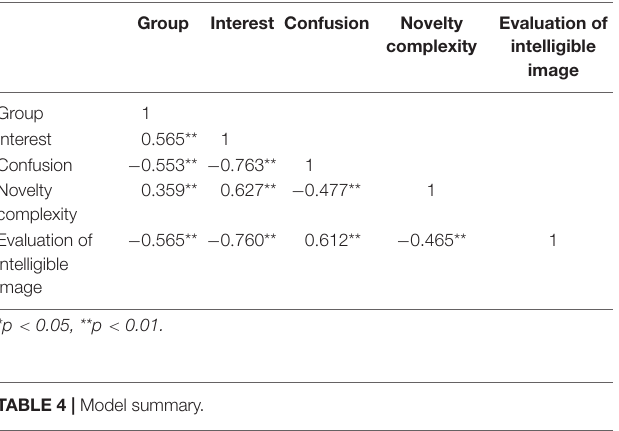
TABLE 5 | ANOVA a .